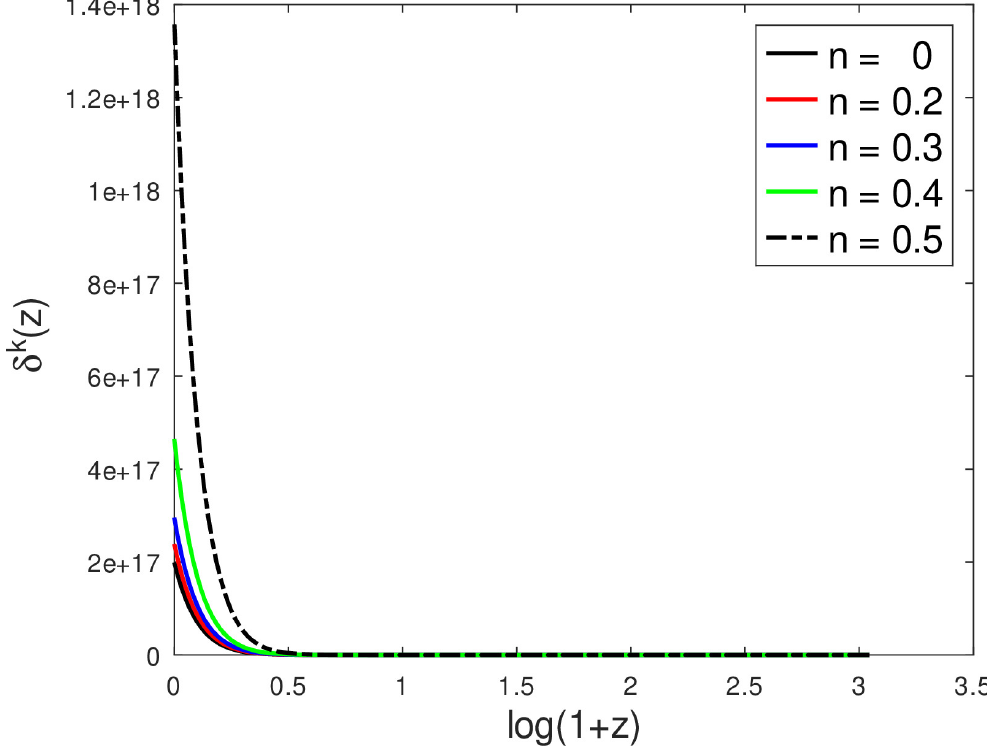
Figure 13. The variation of the matter density perturbations δ k ( z ) for a viscous Bianchi type-V cosmological model vs. redshift for γ = 4, β = 1 and n = 0.2 and different values of α